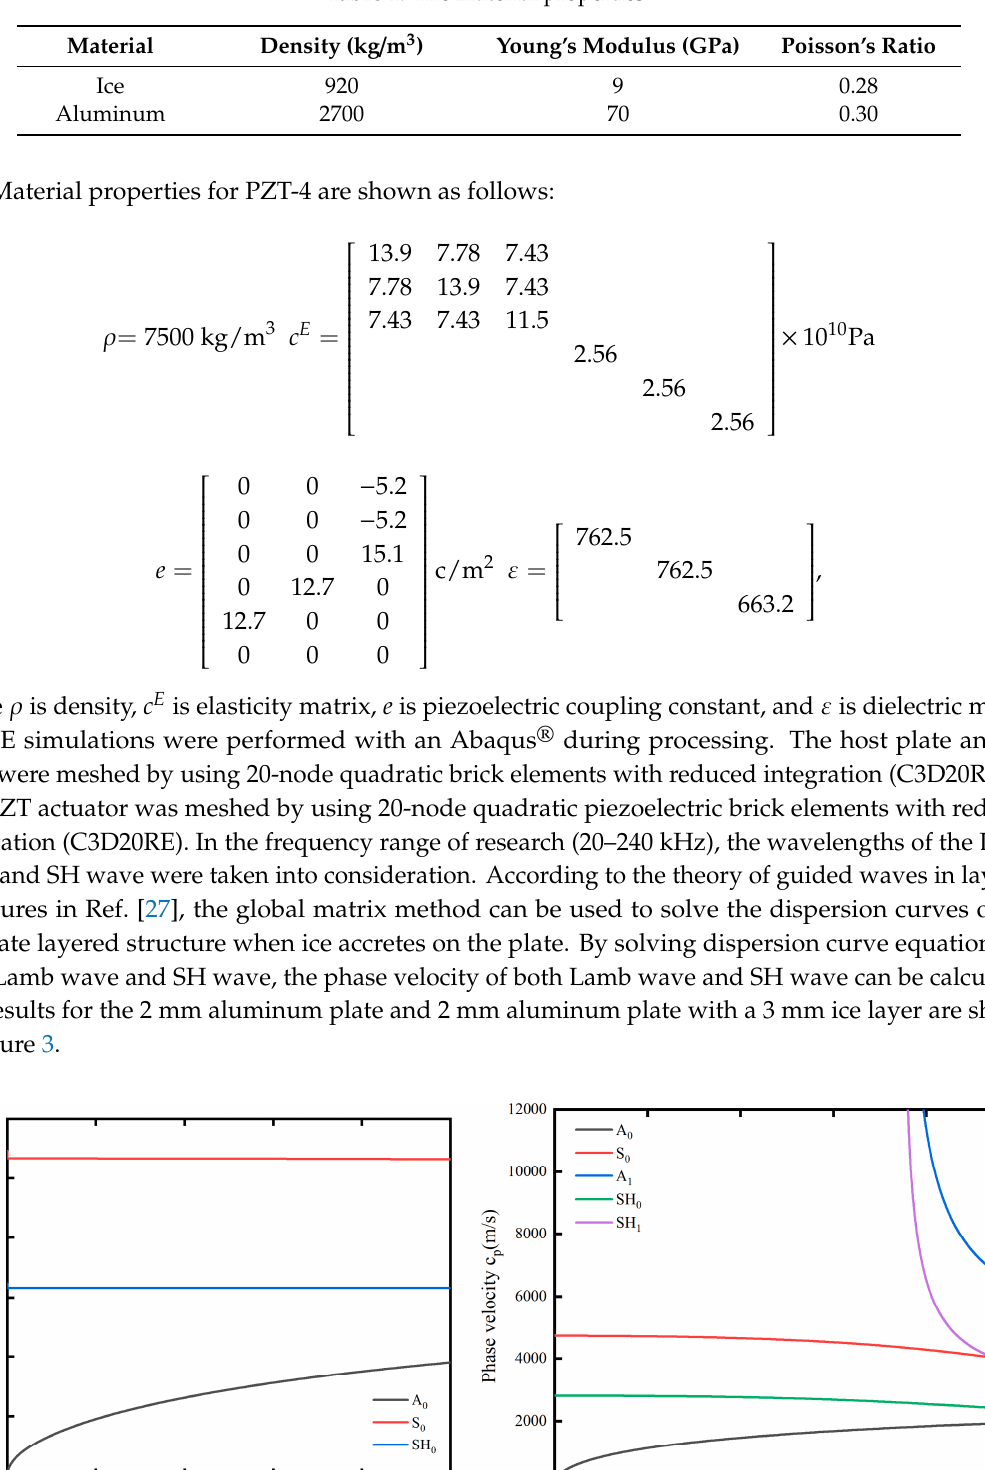
Table 1. The material properties.